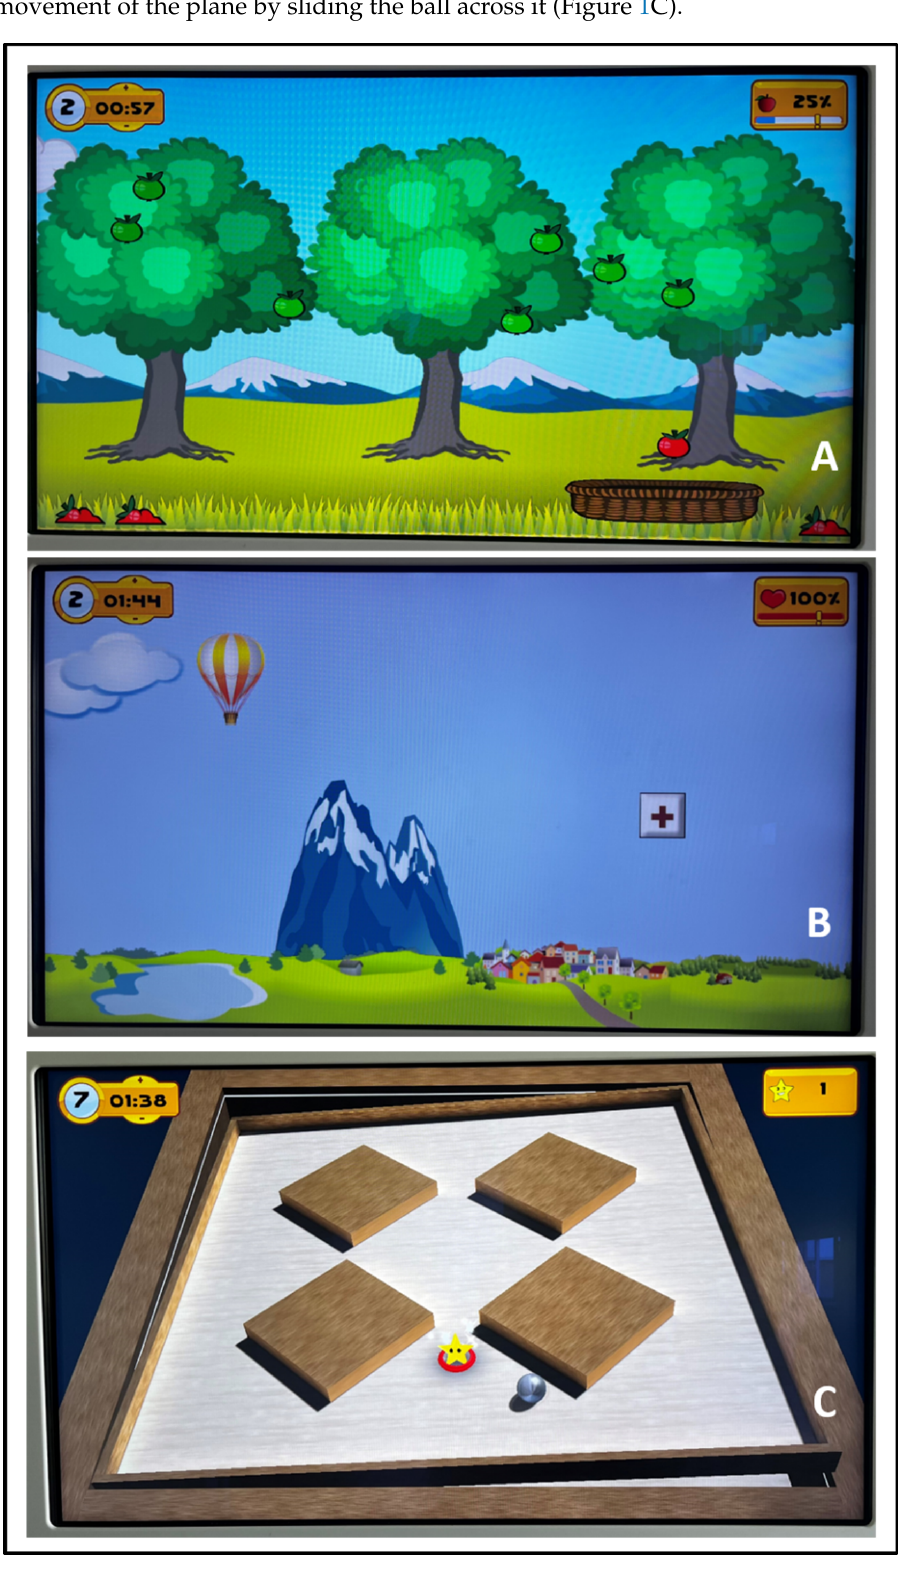
Figure 1. Examples of non-immersive virtual exergame provided by the Tymo ® system. ( A ): Non- immersive virtual exergame ‘apple picking’; ( B ): non-immersive virtual exergame ‘the hot-air balloon’; ( C ): non-immersive virtual exergame ‘the labyrinth’.